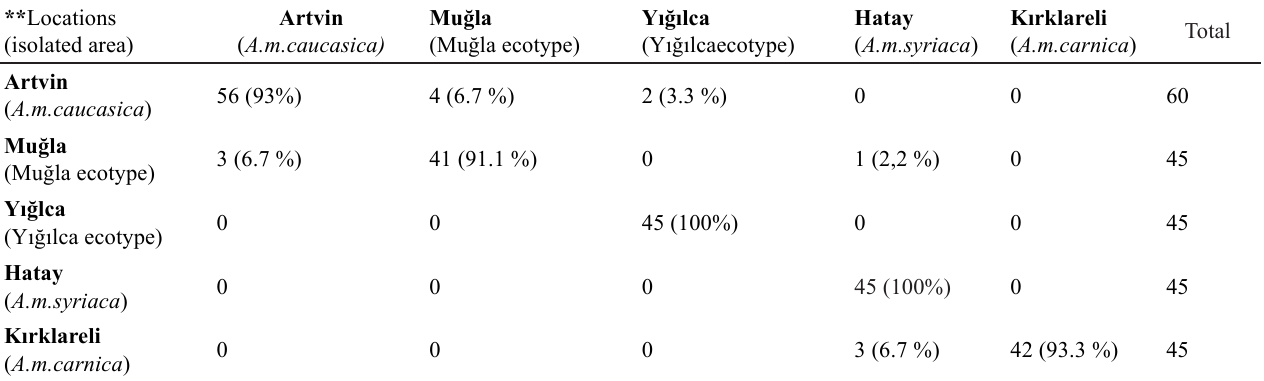
Table 2. Predicted group membership of honeybee samples from isolated areas including native Anatolian honeybee races.